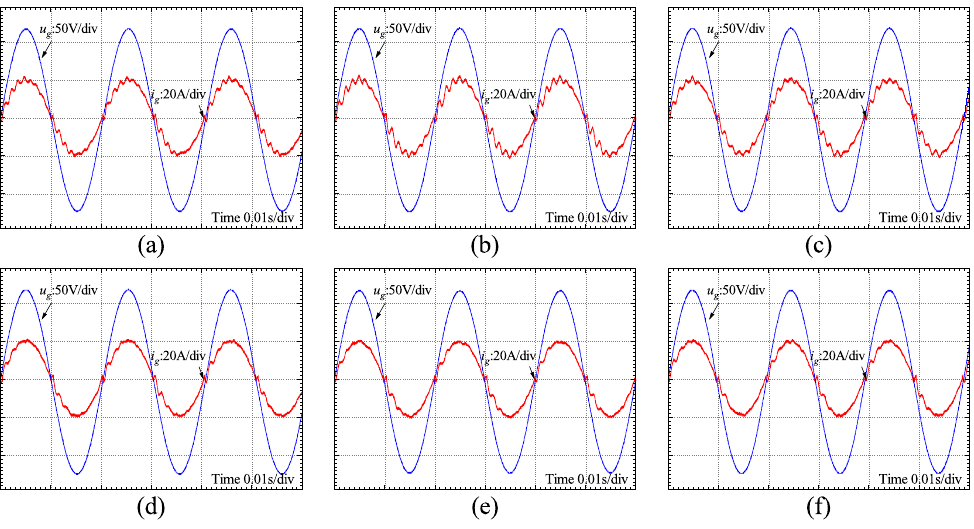
Figure 20. The waveform of grid voltage u g and grid current i g when L 2 varies to 4 mH. ( a – c ): using FIR filters when the grid frequency is 49 Hz, 50 Hz, and 51 Hz. ( d – f ): using IIR filters when the grid frequency is 49 Hz, 50 Hz, and 51